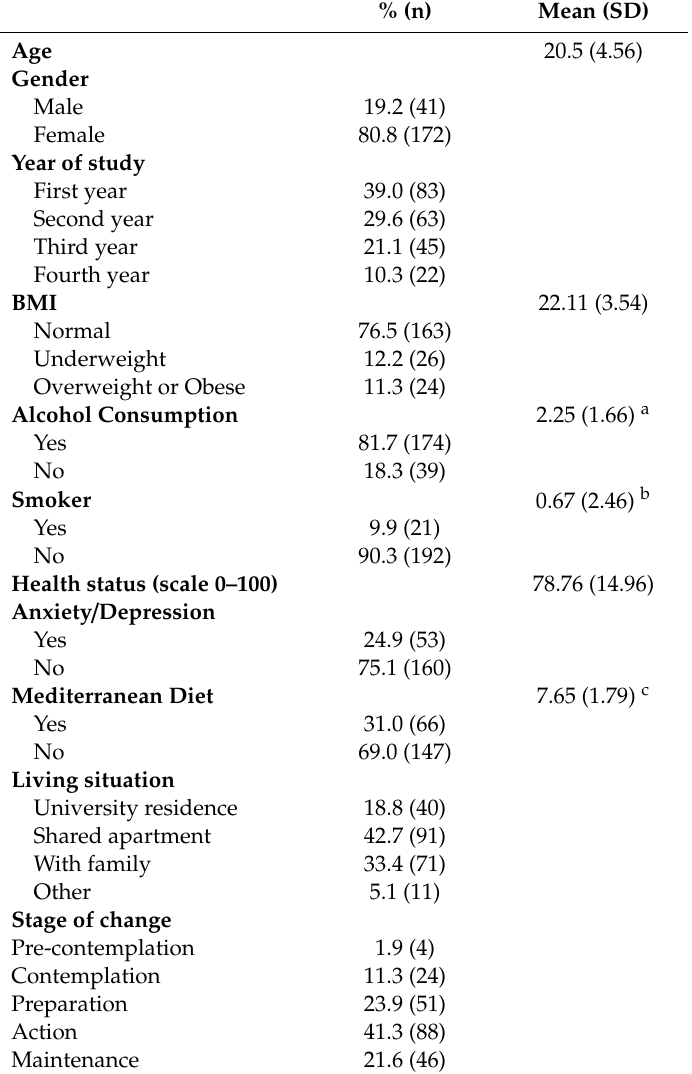
Table 1. Descriptive characteristics of the